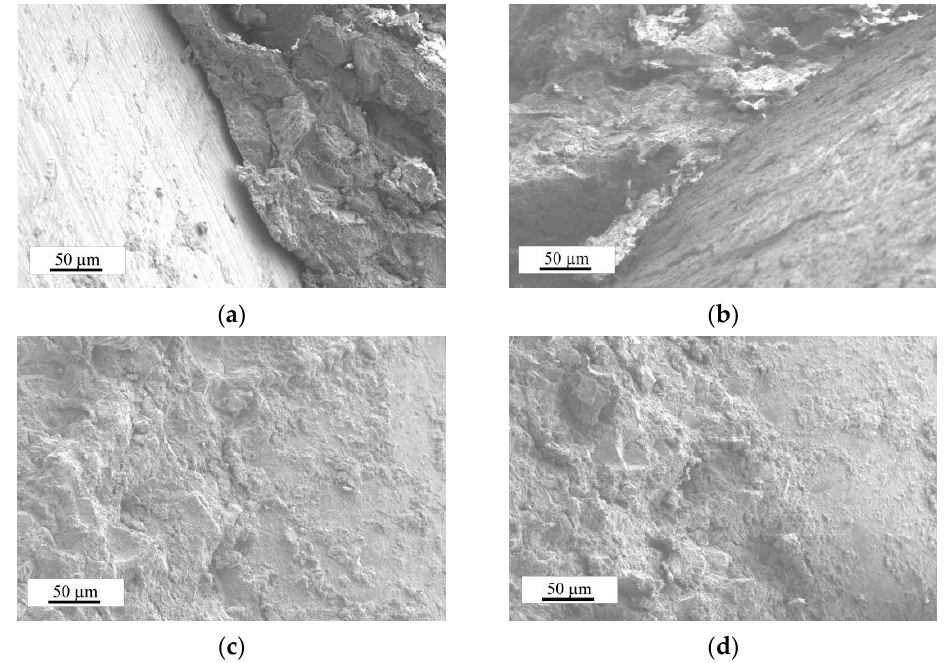
Figure 10. SEM image of the composition sample: ( a ) PA; ( b ) PAMK; ( c ) PAS; ( d ) PASMK.